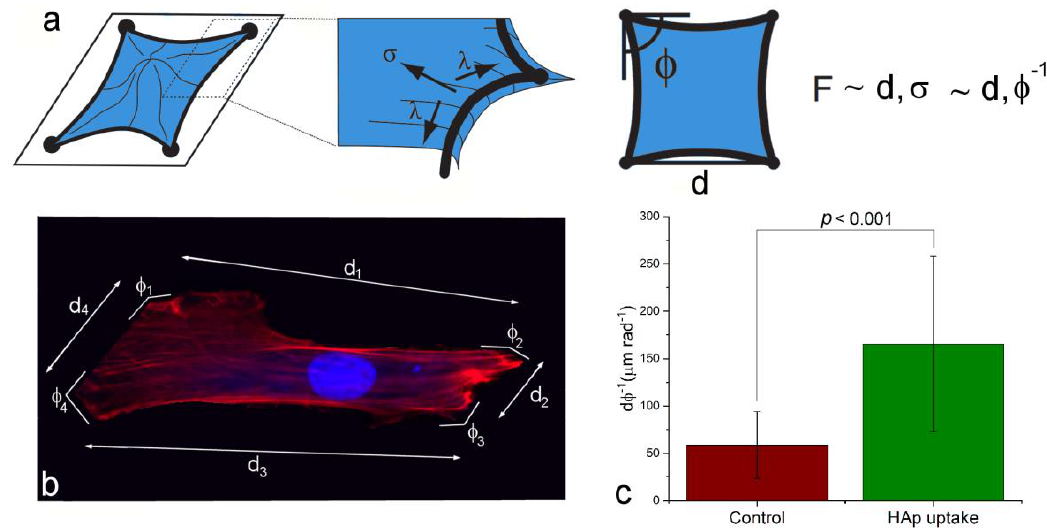
Figure 9. Schematization of the discrete adhesion model proposed by Bischofs et al., and applied to estimate the force of adhesion of the cells to the underlying surface ( a ) . The model predicts the direct dependence of the adhesion force on the cell dimensions defined by the cell side length, d, and on the surface tension, σ. The surface tension can be further expressed as inversely proportional to the opening angle at the cell corners, ϕ, as direct adhesion sites. A representative hMSC stained for f-actin in red and the nucleus in blue, along with the derived parameters d and ϕ ( b ). Comparison of d/ϕ ratio directly indicative of the adhesion force for the control, untreated hMSCs and for hMSCs that underwent HAp nanoparticle uptake ( c ). Data points represent averages (n = 16), error bars represent standard deviation, and p-value represents the confidence interval for the statistical significance of the difference of the value of the sample group compared to the control.